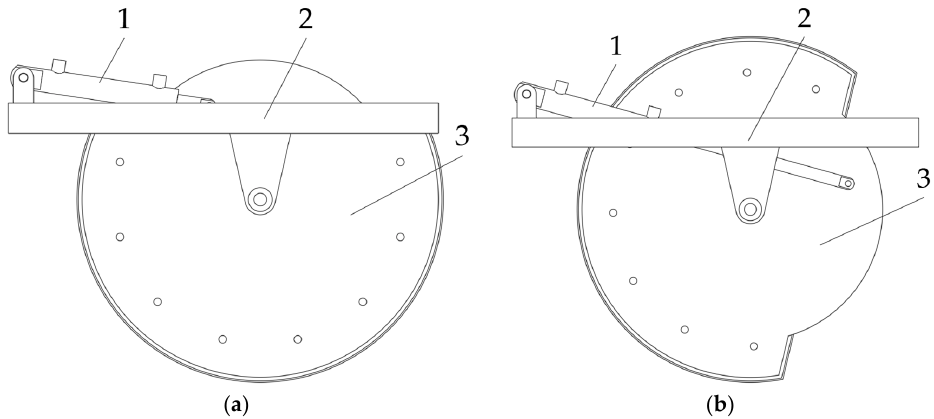
Figure 10. ( a ) Diagram of the state of the residual- fi lm collecting and bundling device when collect-